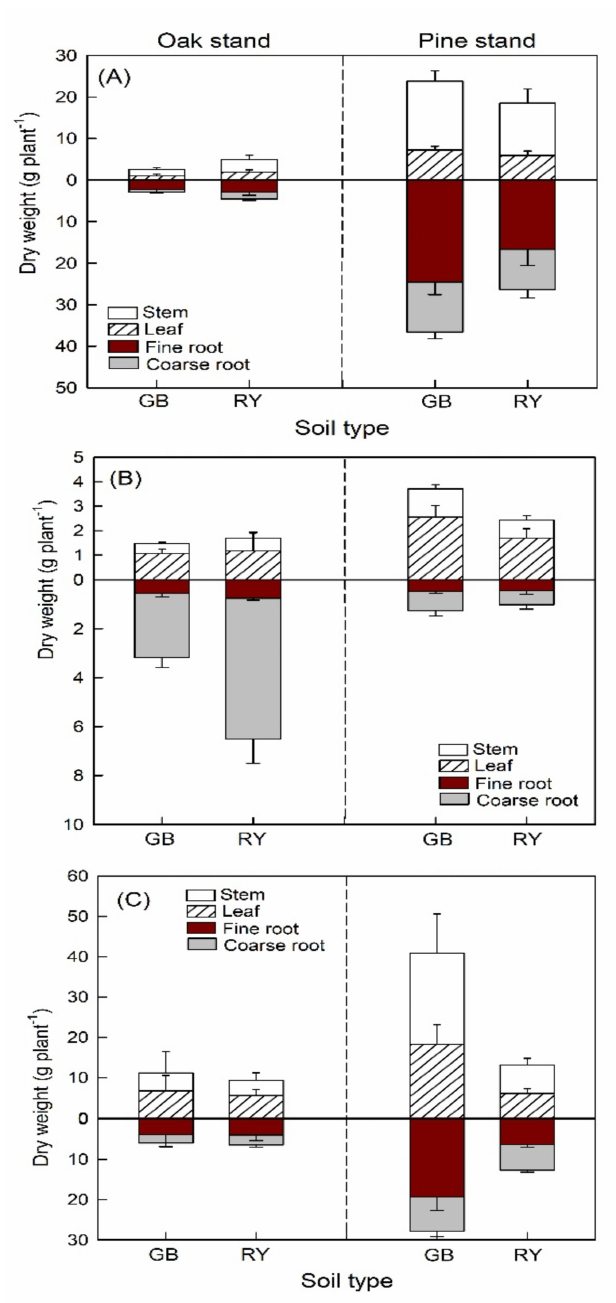
Figure 4. Biomass growth of ( A ) Fraxinus rhynchophylla , ( B ) Pinus koraiensis , and ( C ) Zelkova serrata in different soil and forest stands at harvesting